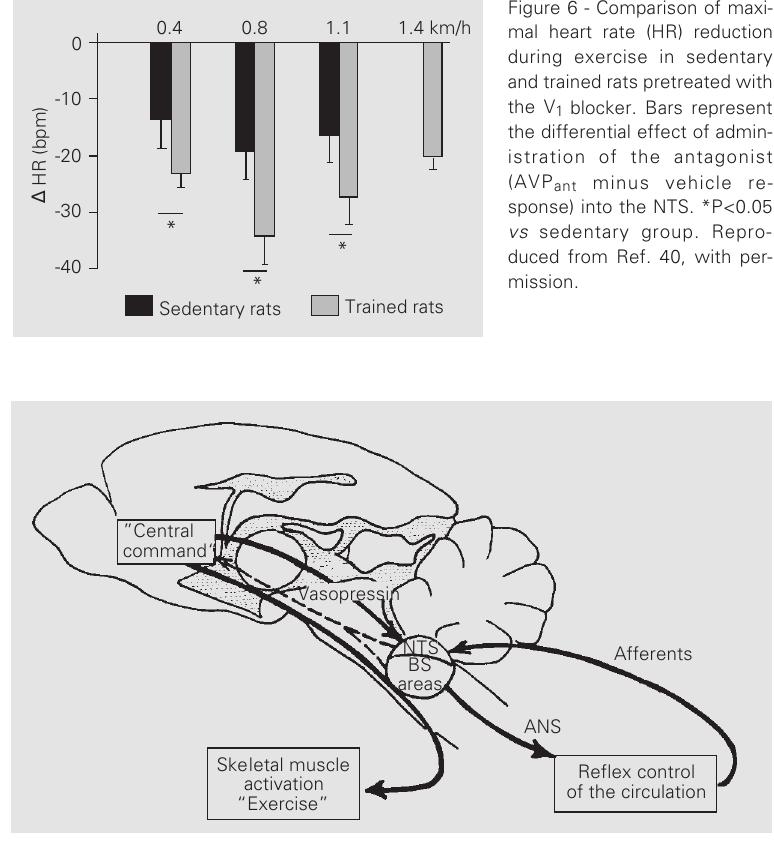
Figure 7 - Proposed vasopressinergic link to adjust the feed-forward (“central command”) and feedback controllers of the circulation during exercise. The dashed line represents the peripheral encoded information (from afferents) from cardiovascular effectors conveyed by the nucleus tractus solitarii (NTS) and other brainstem areas (BS) to suprabulbar integrative centers. ANS, Autonomic nervous